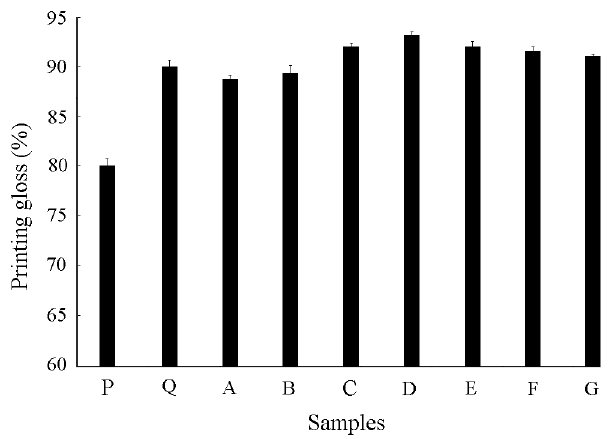
Figure 8. Glossiness of inkjet printing before and after coating.